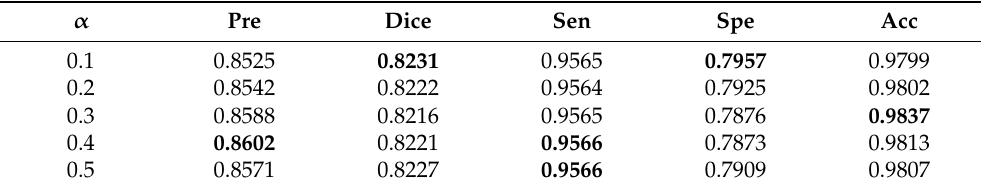
Table 5. Influence of α balance coefficient on LSW-Net + IAC-Loss model segmentation result